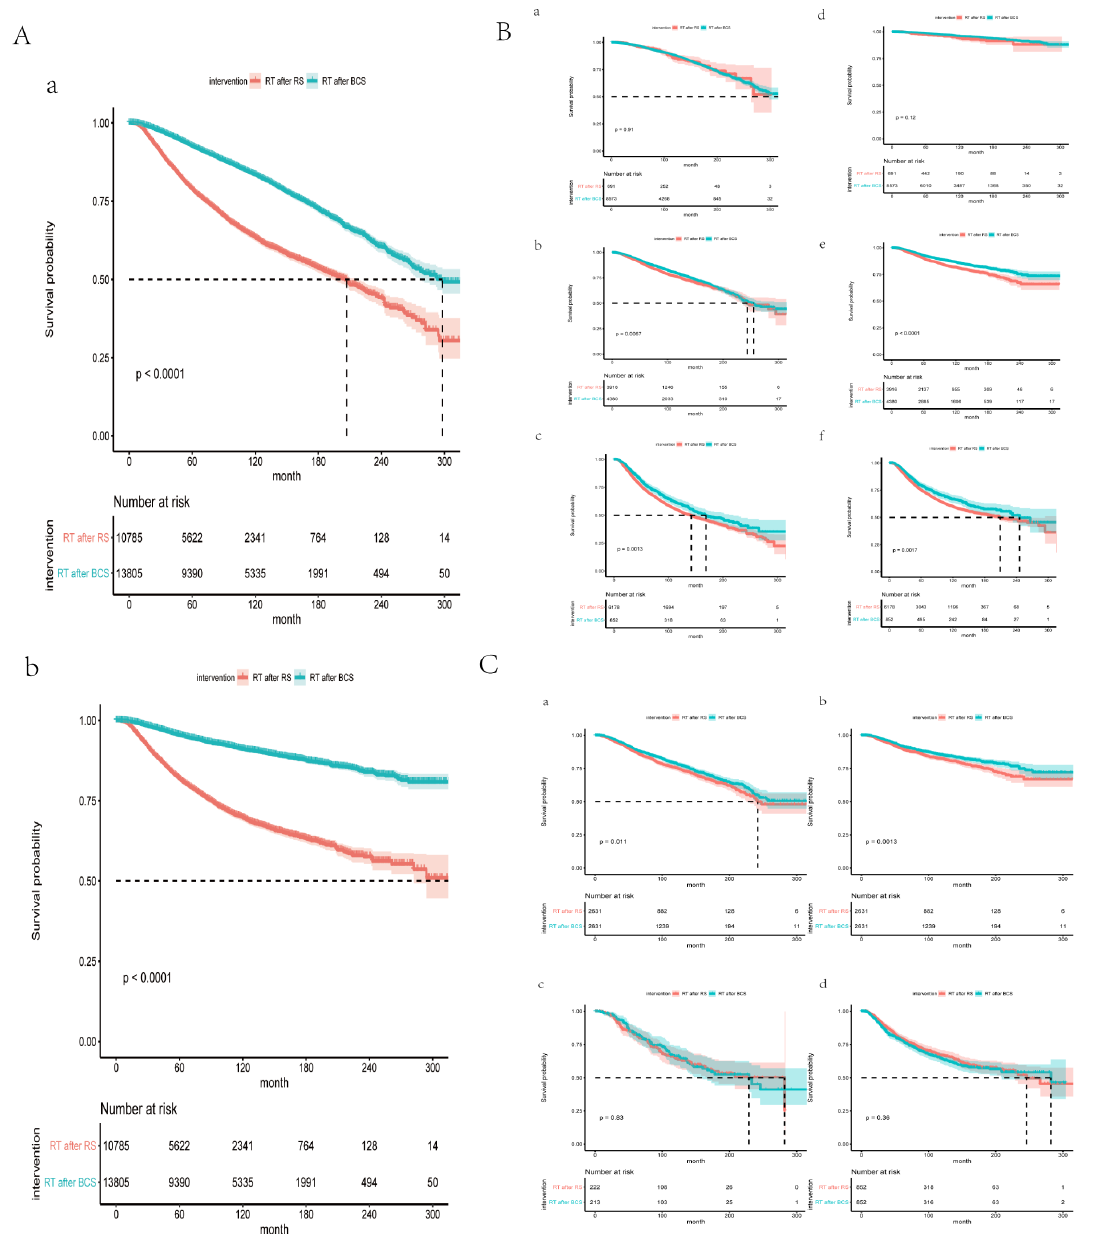
Figure 2. Survival analysis. ( A ) Meier survival curve of all breast cancer patients. ( a ) Meier survival curve on OS, ( b ) Meier survival curve on BCSS. ( B ) Survival curve of stage I, II, and III patients before PSM on OS and BCSS. ( a ) Meier survival curve of stage I breast patients before PSM for OS, p = 0.91. ( b ) Meier survival curve of stage II breast patients before PSM for OS, p = 0.0067. ( c ) Meier survival curve of stage III breast patients before PSM for OS, p = 0.0013. ( d ) Meier survival curve of stage I breast patients before PSM for BCSS, p = 0.12. ( e ) Meier survival curve of stage II breast patients before PSM for BCSS, p < 0.0001. ( f ) Meier survival curve of stage III breast patients before PSM for BCSS, p = 0.0017. ( C ) Survival curve of stage II and III breast patients after PSM on OS and BCSS. ( a ) Meier survival curve of stage II breast patients after PSM for OS, p = 0.011. ( b ) Meier survival curve of stage II breast patients after PSM for BCSS, p = 0.0013. ( c ) Meier survival curve of stage III breast patients after PSM for OS, p = 0.83. ( d ) Meier survival curve of stage III breast patients after PSM for BCSS, p =